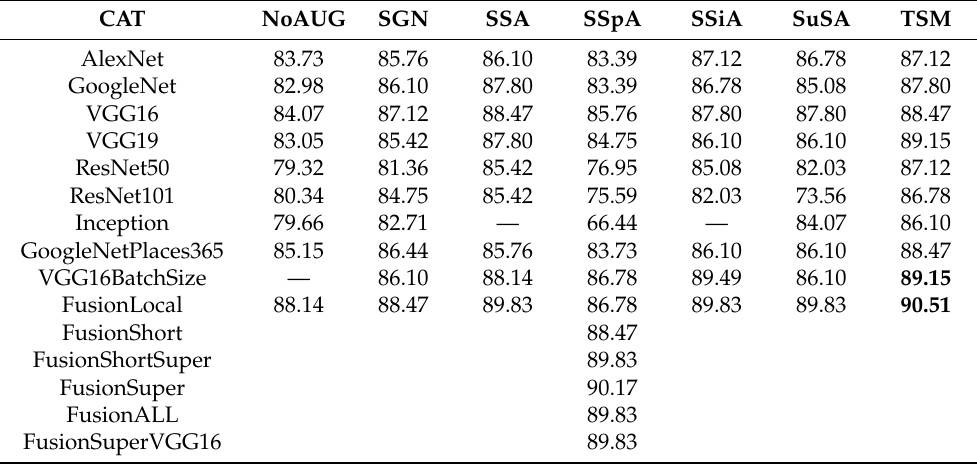
Table 2. Performance on the CAT (mean accuracy over ten-fold cross-validation). Values of interest are in bold.